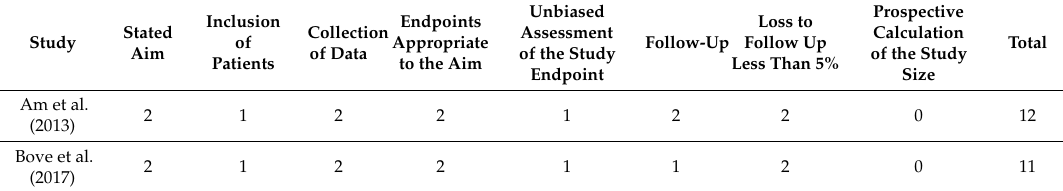
Table 4. MINORS (Methodological Index for Non-Randomized Studies)